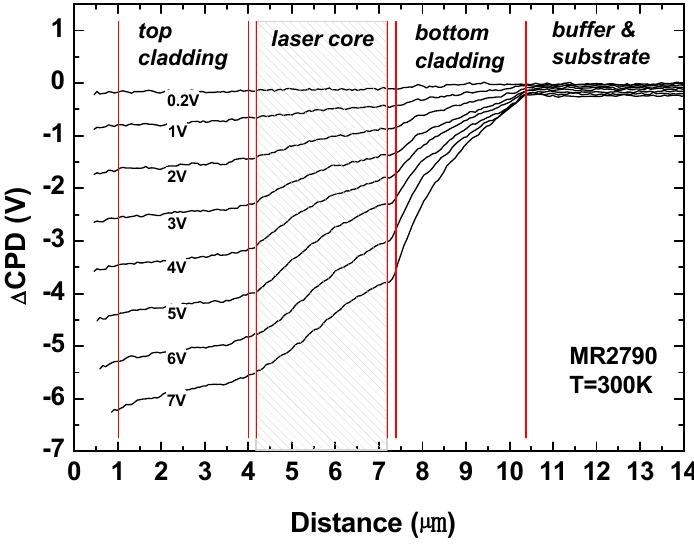
Figure 3. Contact potential difference profiles for the GaAs-based QCL with AlInP claddings measured on the cleaved laser facet by KPFM technique for various applied bias.